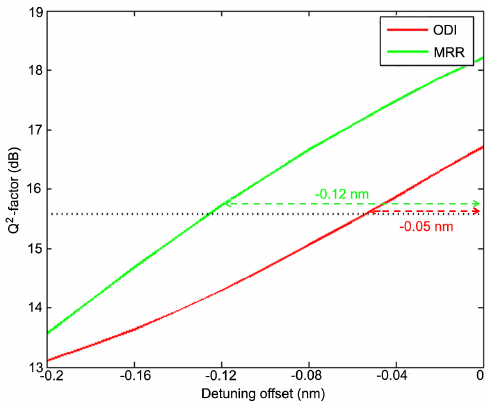
Figure 10. Q 2 -factor for different detuning offset values for ODI (red color) and MRR (green color). The zero detuning refers to the case that the notch of the filters is located away from the data carrier by so many spectral units as defined in Figure 5.